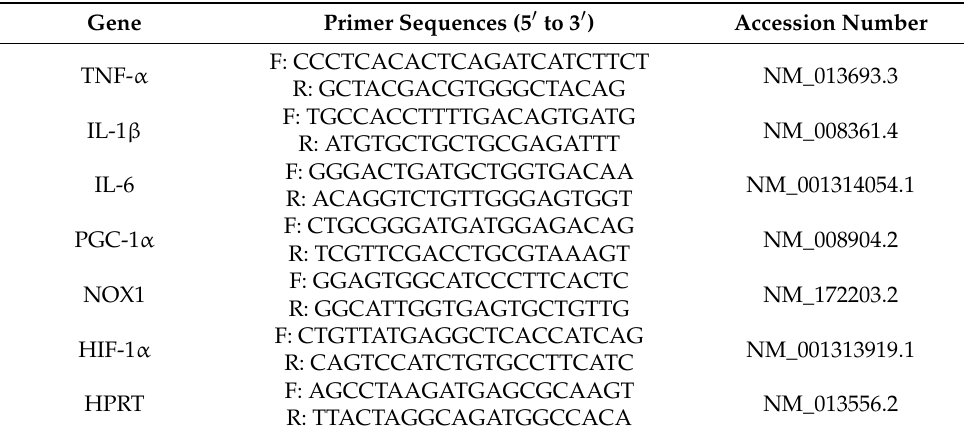
Figure 4. Muscle mRNA expressions of inflammatory genes. The groups are described in the legend to Table 1, and gene abbreviations are given in the footnotes to Table 2. Student’s t -test was used to analyze differences between the C and S groups at the same time point. Differences among septic groups on the same day were analyzed by a one-way ANOVA with Tukey’s post-hoc test. * Signi fi cantly di ff ers from the C group. † Signi fi cantly di ff ers from the S group ( p < 0.05).